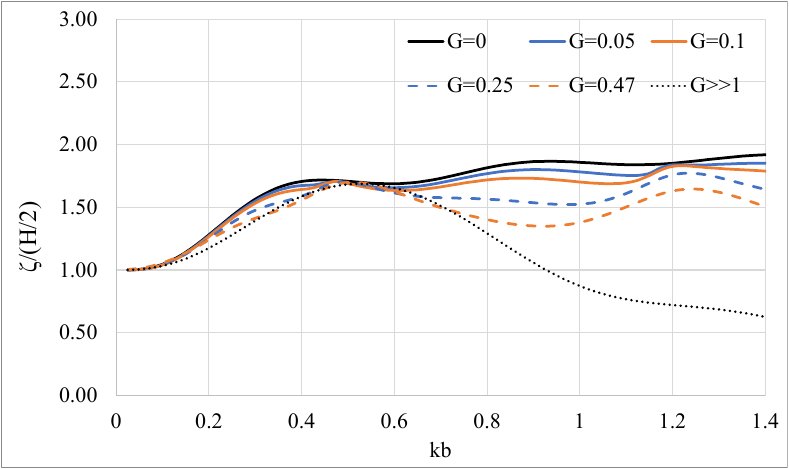
Figure 10. Effect of the porous coefficient 𝐺 on the wave run up of a porous bottom-mounted com- pound cylindrical body.